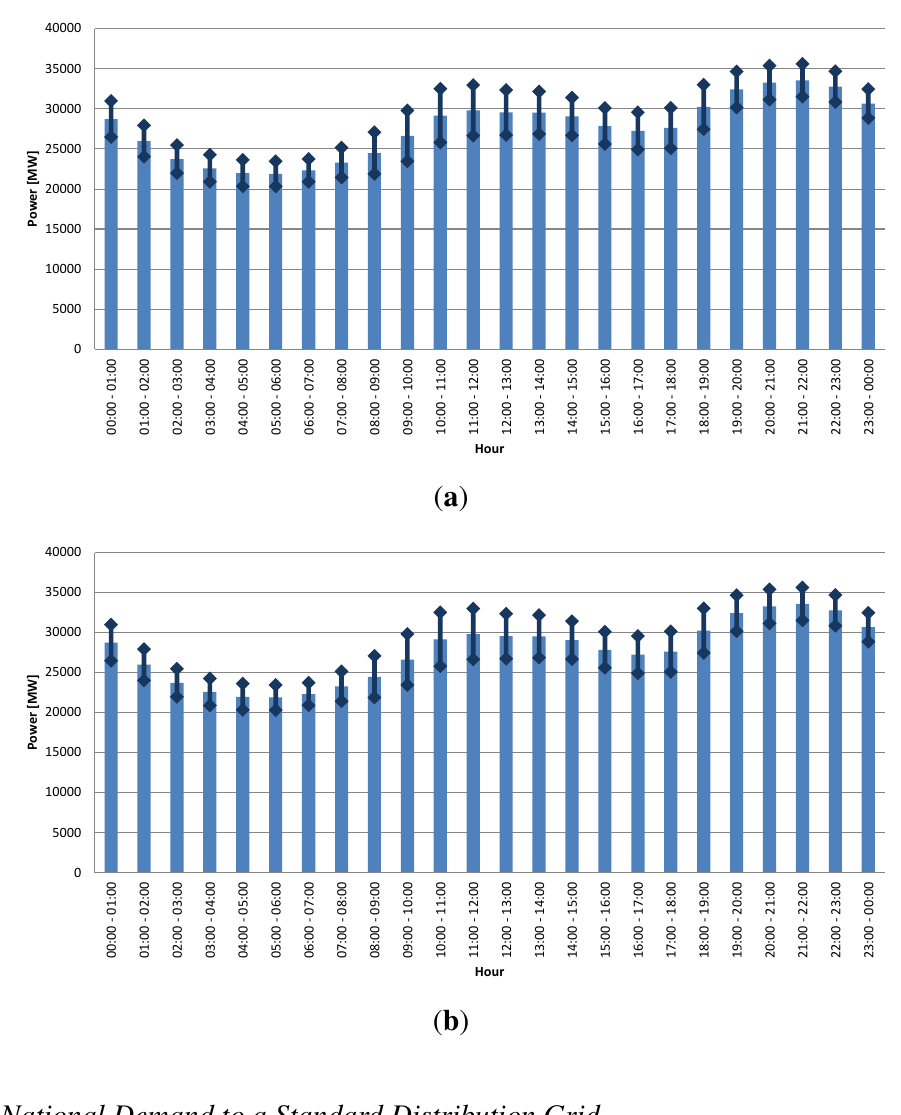
Figure 3. Variation of the overall demand on a labour winter day of Spain. ( a ) Mean, maximum and minimum value of the power demand; ( b ) Standard deviation of the power